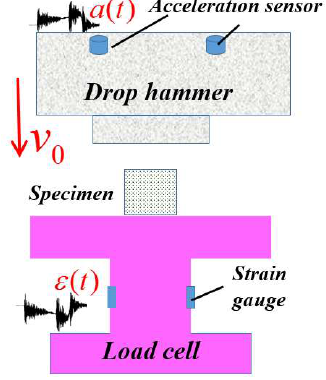
Figure 2. Sketch map of drop-weight tests.